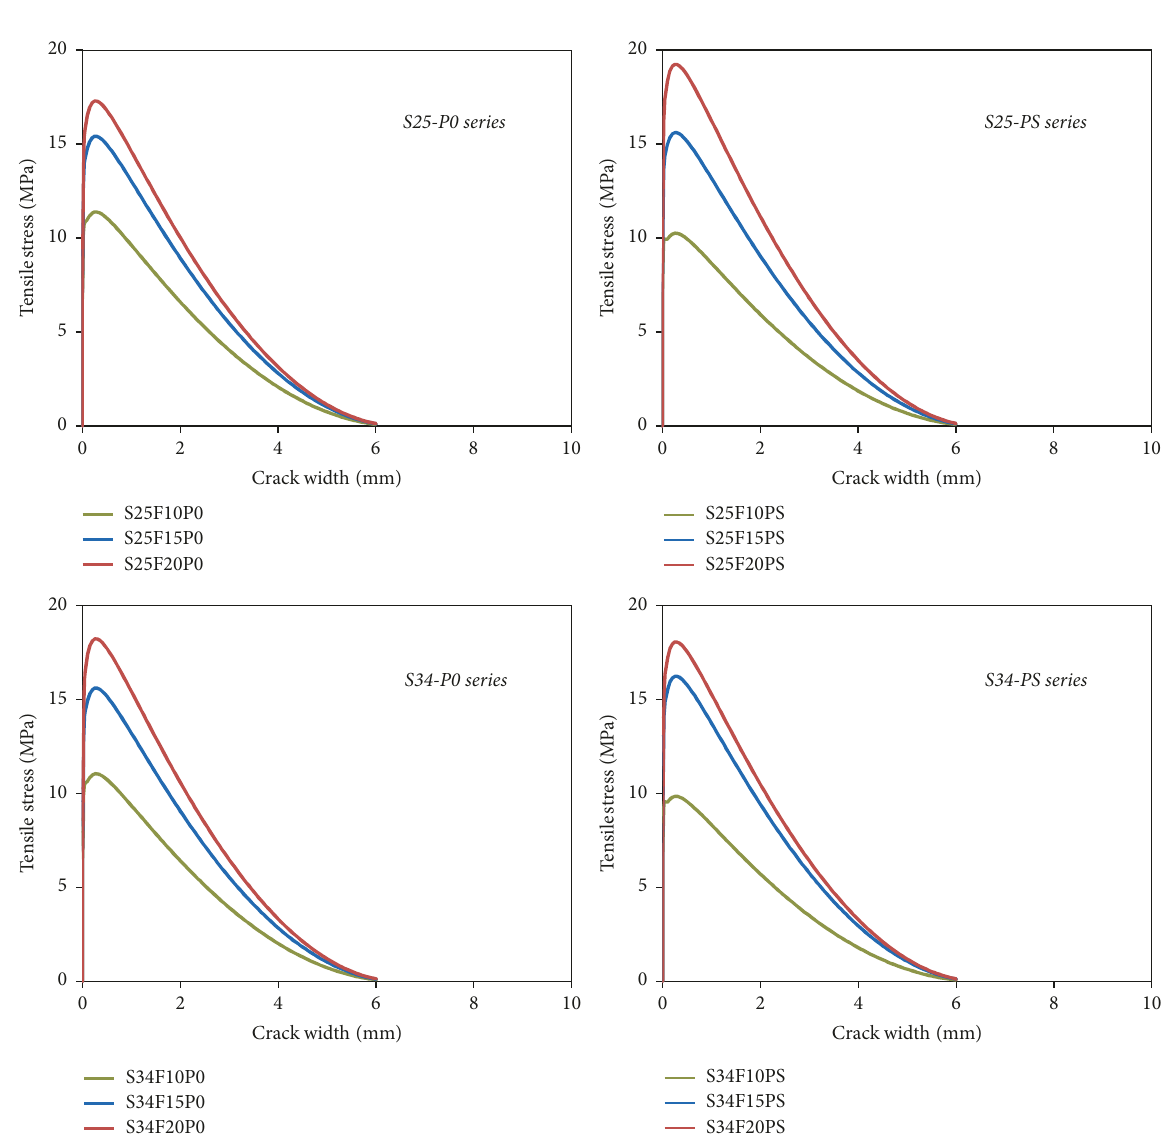
Figure 6: Tensile behavior of UHPFRC evaluated through the proposed inverse analysis with the